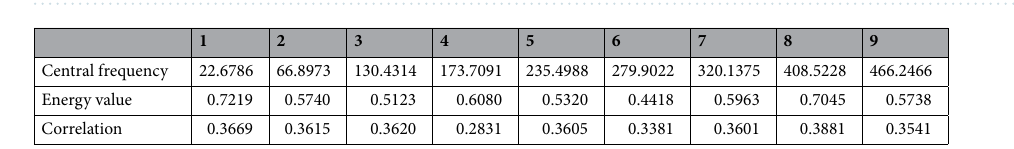
Figure 12. The nine mode components of VMD decomposition.